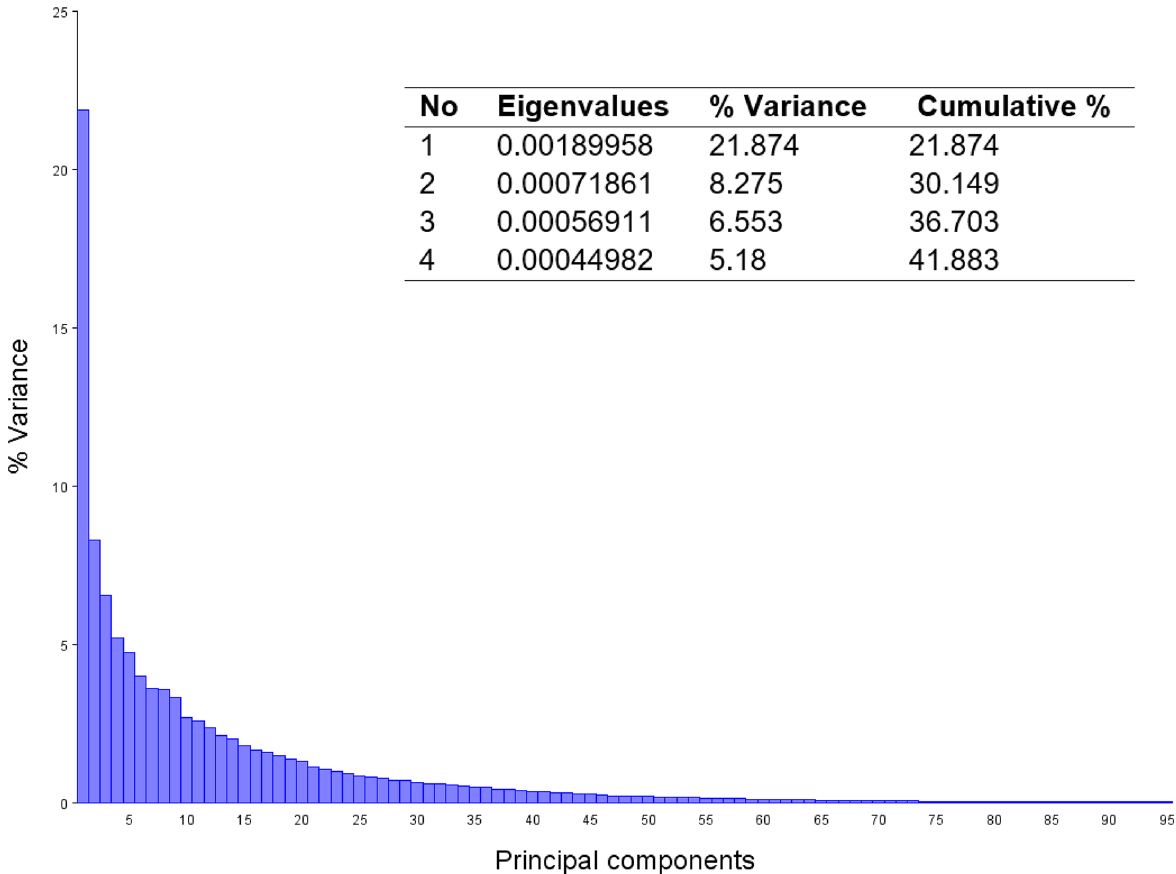
Fig. 2 Eigenvalues with the results of the first four principal components, which explained 42% of